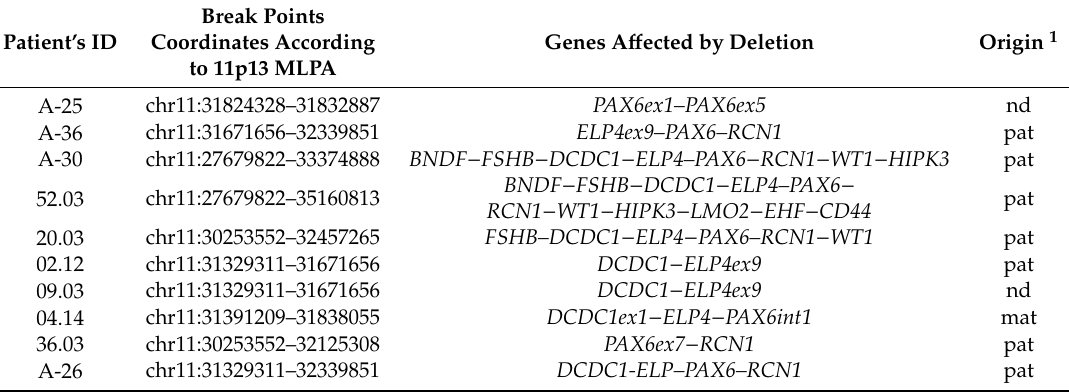
Table 1. Patients with de novo deletions of 11p13 region.